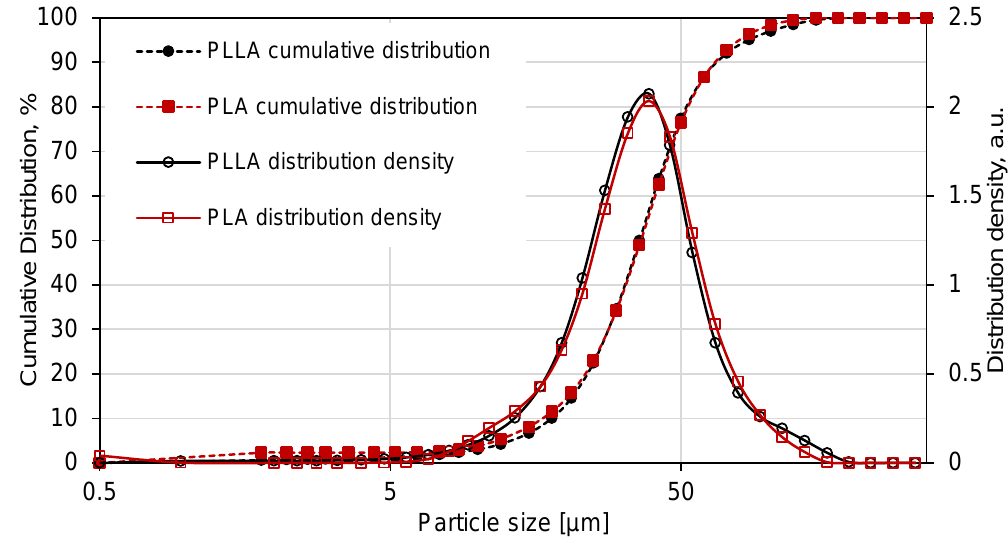
Figure 2. Cumulative distribution and distribution density of PLA and PLLA. Table 1. First avalanche angle (AA), flowing angle ( α f ), cohesive index ( σ f ), and particle size distribution of the prepared PLA and PLLA powders Sample